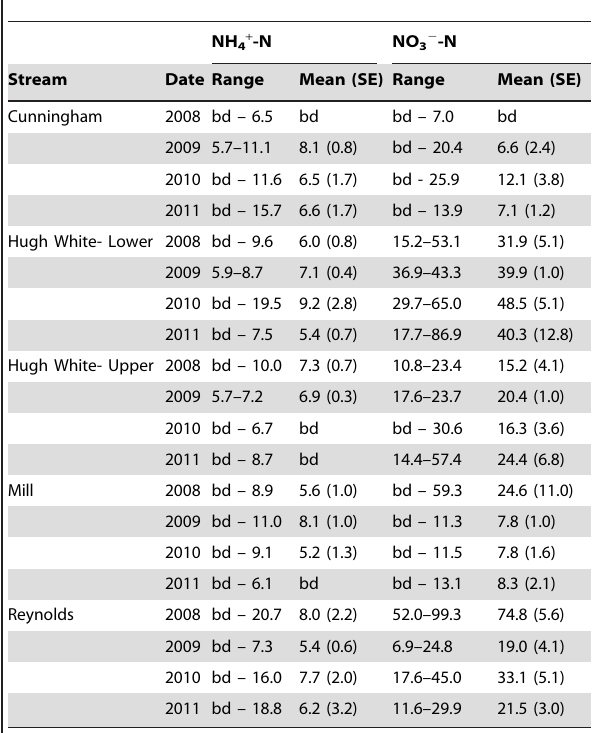
Table 2. Background nutrients in Coweeta